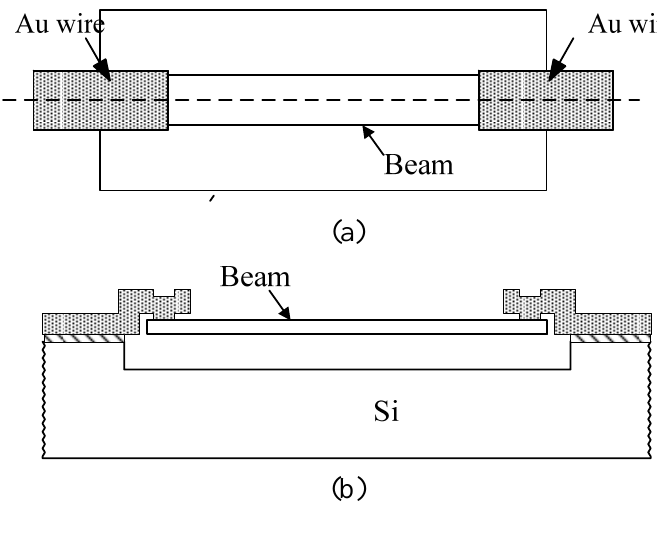
Figure 2. Submicron/nano beam supported by metal wires. (a) Top view. (b) Cross sectional view.